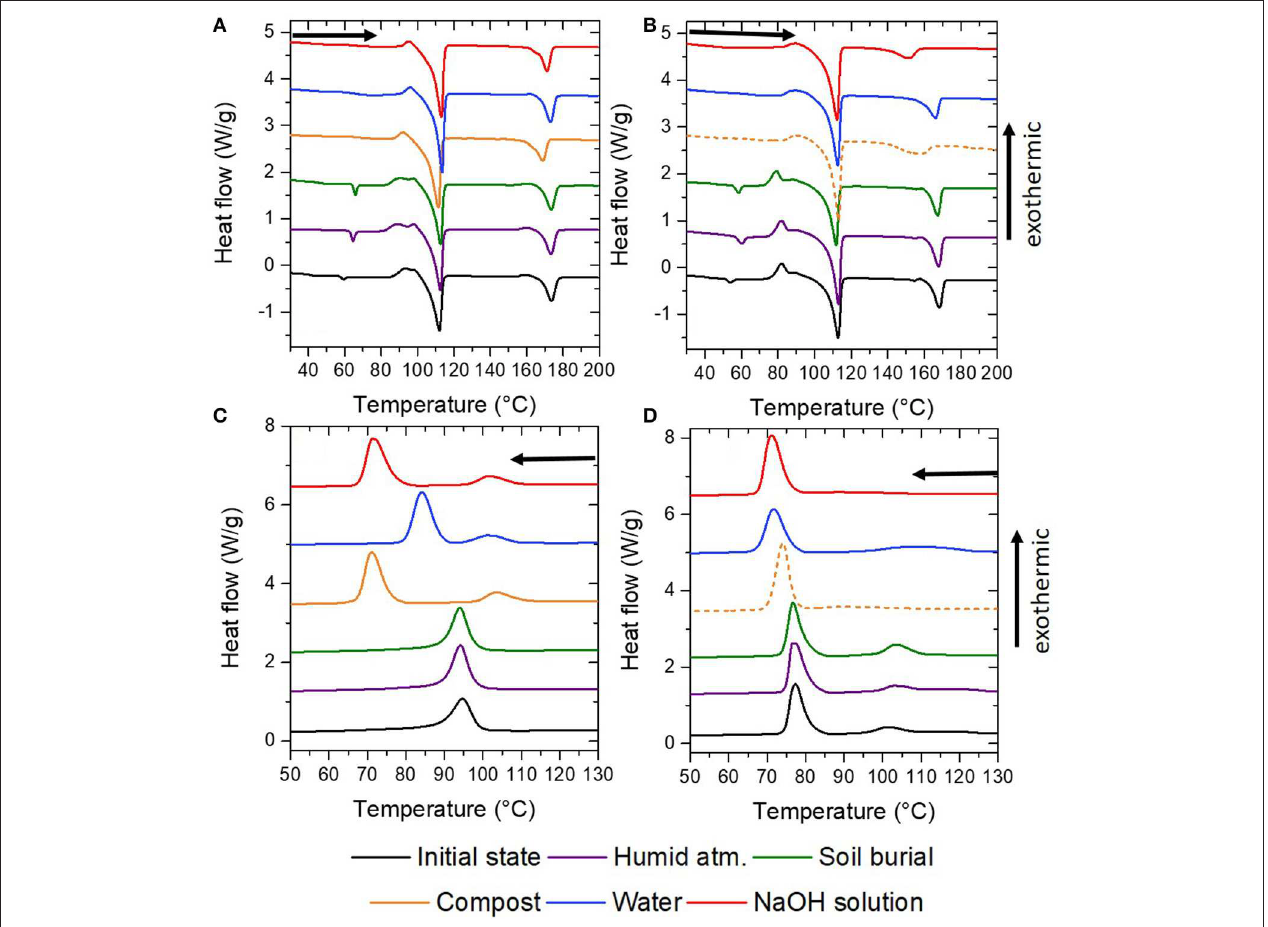
FIGURE 10 | Crystallization and melting curves of poly(butylene succinate) (PBS)/poly(lactic acid) (PLA) blends during cooling and heating ramps at 10 ◦ C/min, before and after degradation. (A,C) PBS/PLA, (B,D) PBS/PLA/deep eutectic solvents (DES). Dashed curves were acquired after 2 months because samples could not be studied in third